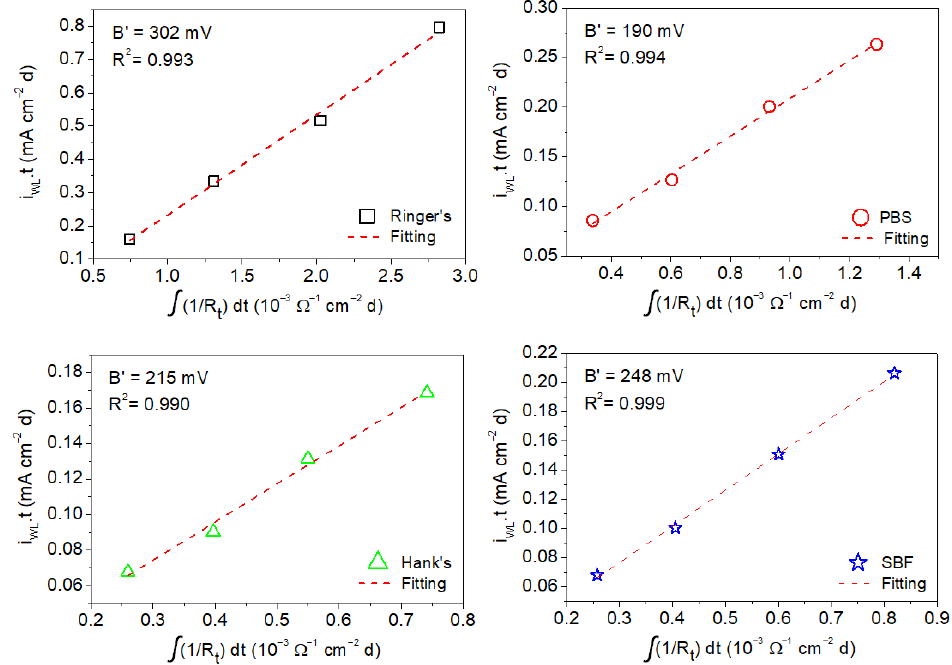
Figure 10. Charge values from weight loss measurements as a function of time-integrated reciprocal of the R t values determined by EIS for AZ31B alloy from measurement in Ringer’s, PBS, Hank’s, and SBF solutions. As expected, the calculated capacitance values obtained for the oxide film (from CPE f ) are one order of magnitude smaller than those obtained for the double layer capacitance (CPE dl ) in all the solutions (Table 6). The small difference between both capacitance values suggests that either the oxide film was formed mainly on small surface areas or the oxide films formed were dynamic and porous and did not form a continuous